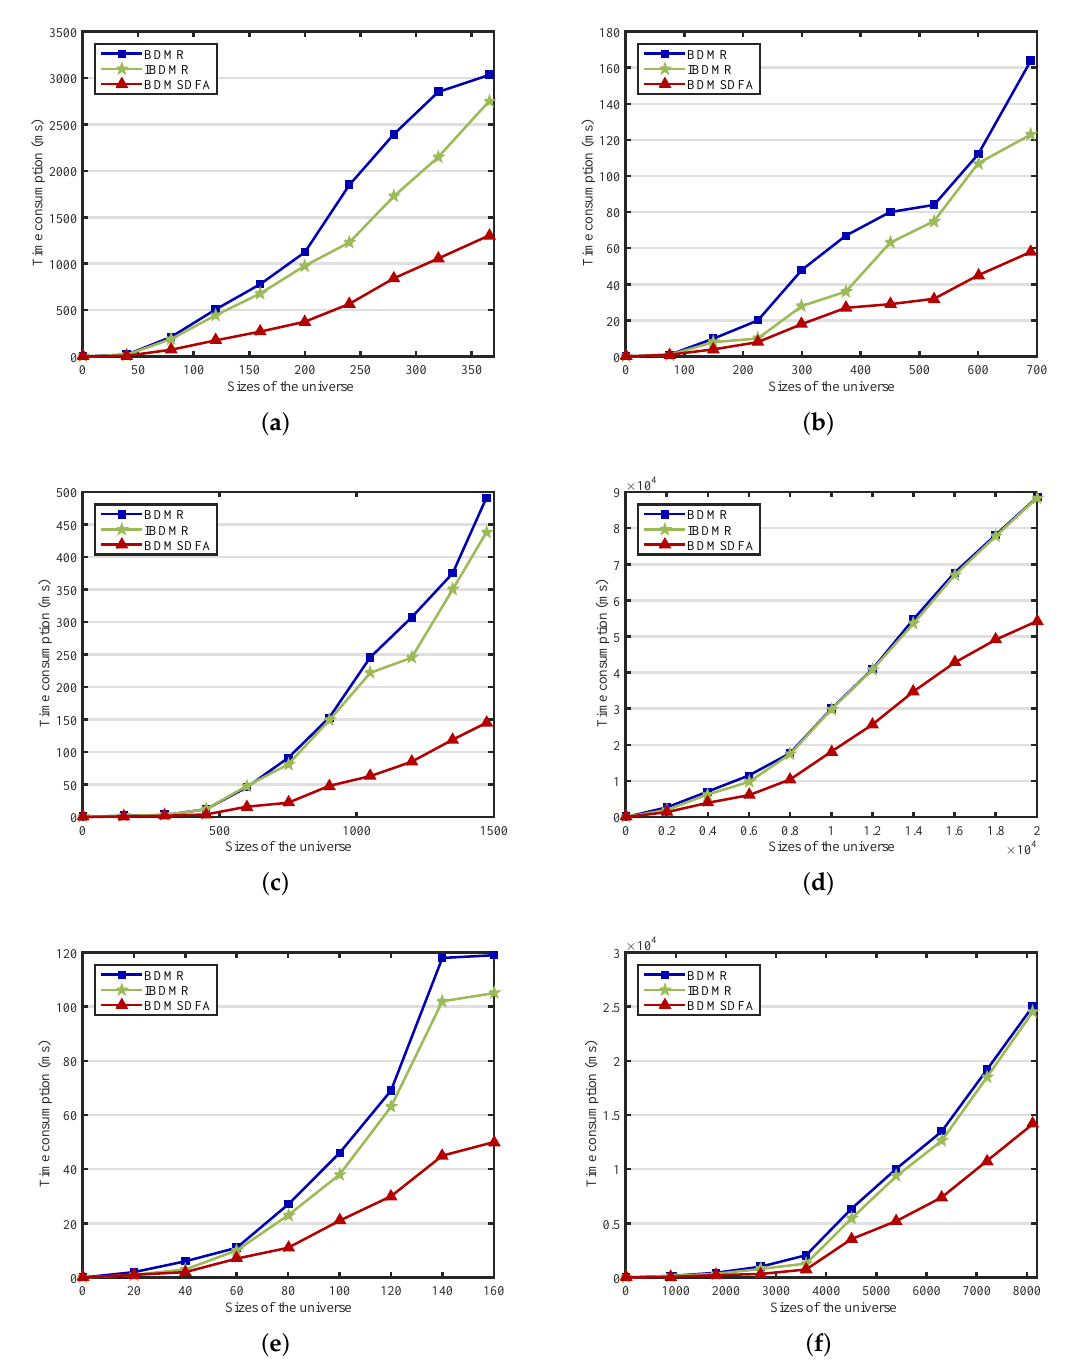
Figure 7. ( a ) Dermatlogy; ( b ) Credit_a; ( c ) Controceptive_Method_Choice; ( d ) Letter; ( e ) Flag; ( f )